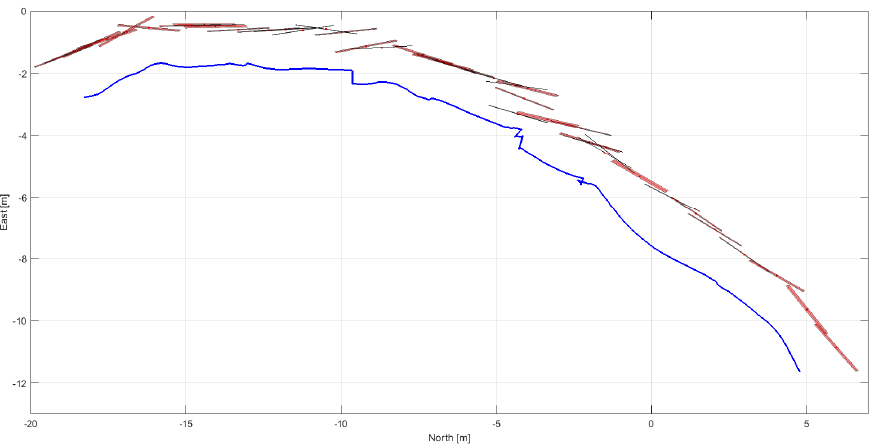
Figure 14. Kalman filter data from leg 3 of the experiment, with the DVL measured planes overlaid seen in the North-East plane.